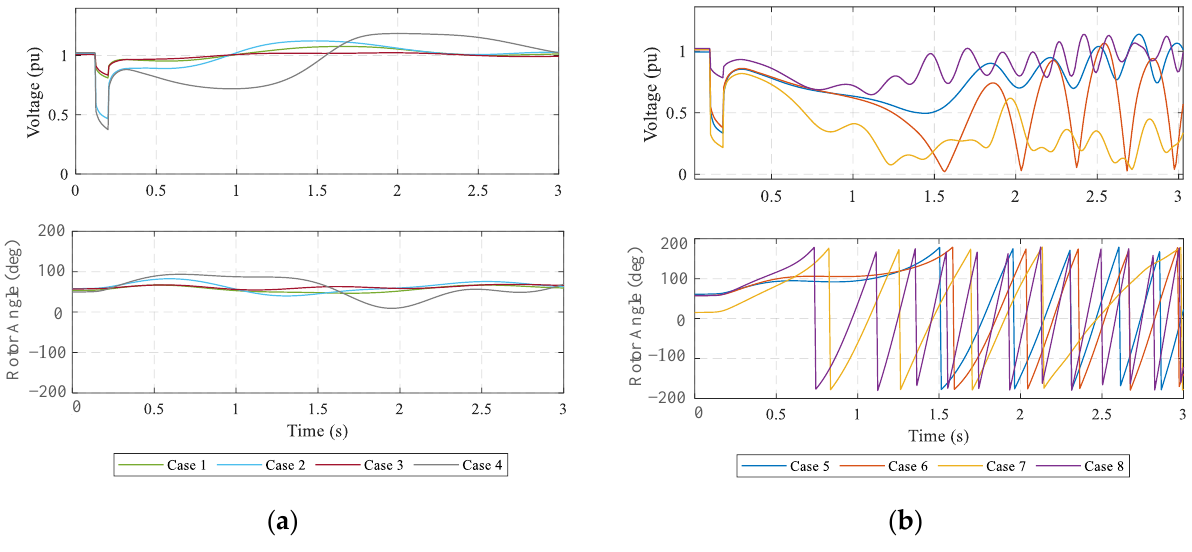
Figure 5. 𝑈 and 𝛿 responses after eight fault cases under different operating scenarios: ( a ) stable; ( b )